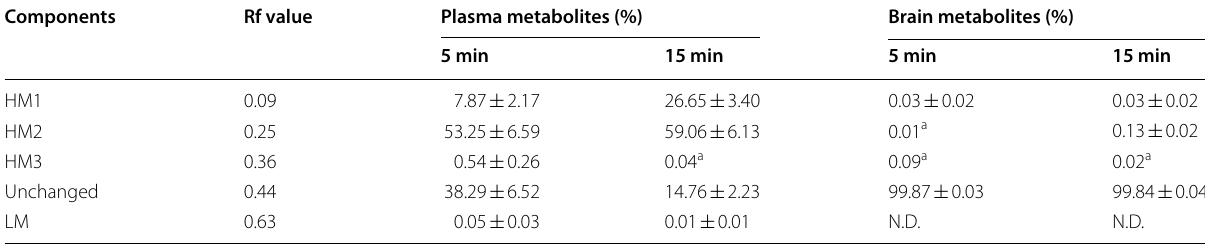
Data represent the mean Detected in two